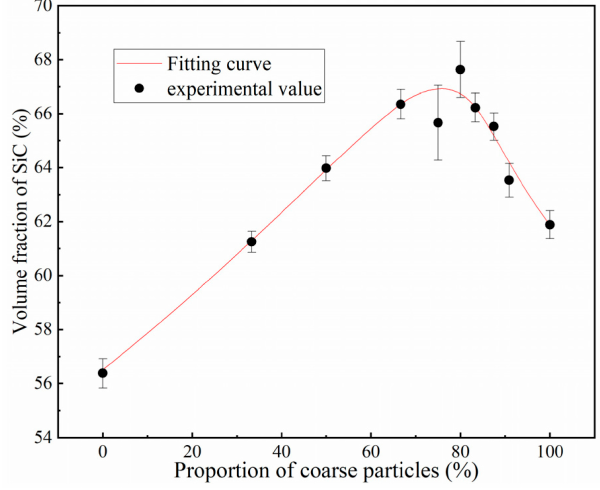
Figure 2. The relationship between the volume fraction of SiC and the proportion of coarse SiC particles (100 μ m).